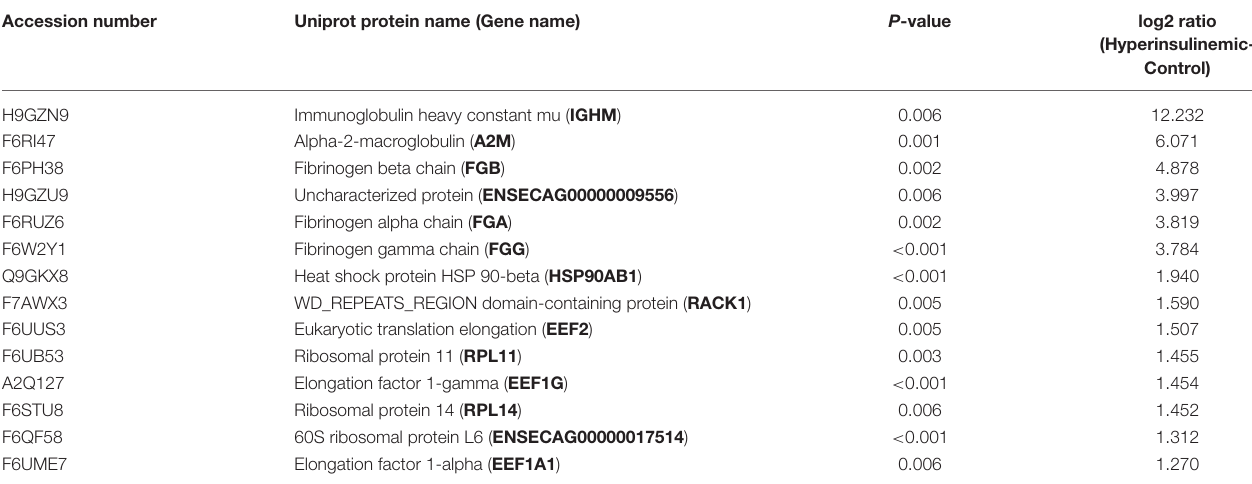
TABLE 3 | Proteins significantly increased in lamellar tissue of hyperinsulinemic horses.